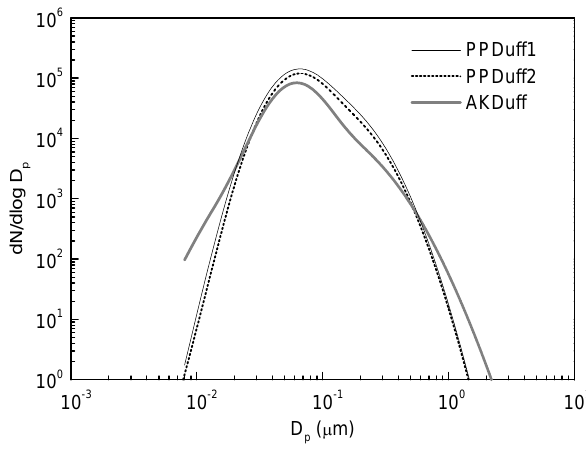
Fig. 3. Number size distribution of tar balls from the smolder- Figure 3 ing combustion of Ponderosa Pine Duff (PPDuff1 and PPDuff2) and Alaskan Tundra Duff (AKDuff) obtained from Electrical Low Pressure Impactor (ELPI) measurements. Each curve represents a four-minute average of second-by-second ELPI retrievals based on spherical, uniform particles and fitted with bi-modal, lognormal size-distribution